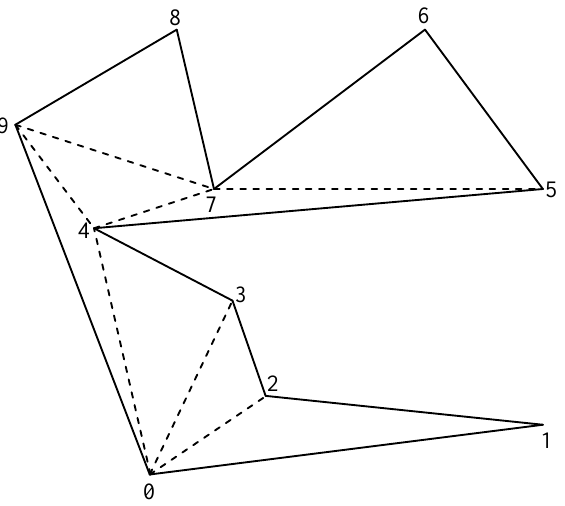
Figure 11: The triangulated